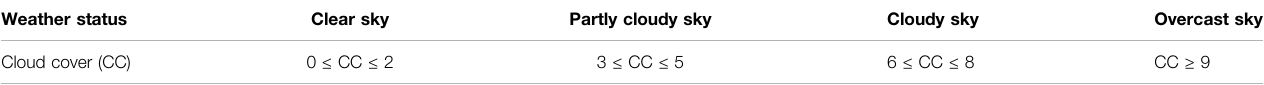
TABLE 1 | Cloud cover coef fi cient. Clear sky Partly cloudy sky Cloudy sky Overcast sky